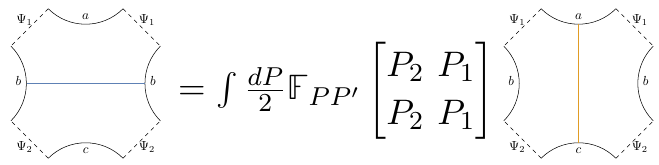
Figure 6 . The boundary T-channel (left) and boundary S-channel (right) decomposition of a boundary four-point function in the case where two (out of the total of four) boundary conditions are identical and pairwise-identical boundary operators. The two channels are related with a holo- morphic copy of the fusion